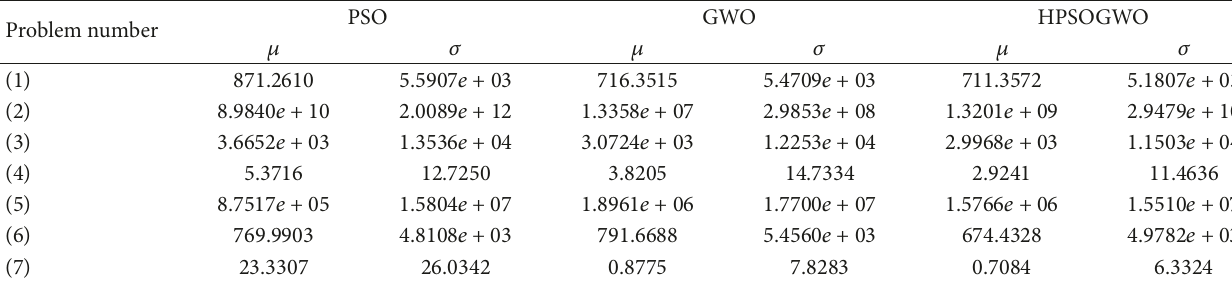
Table 5: PSO, GWO, and HPSOGWO statistical results of unimodal benchmark functions.